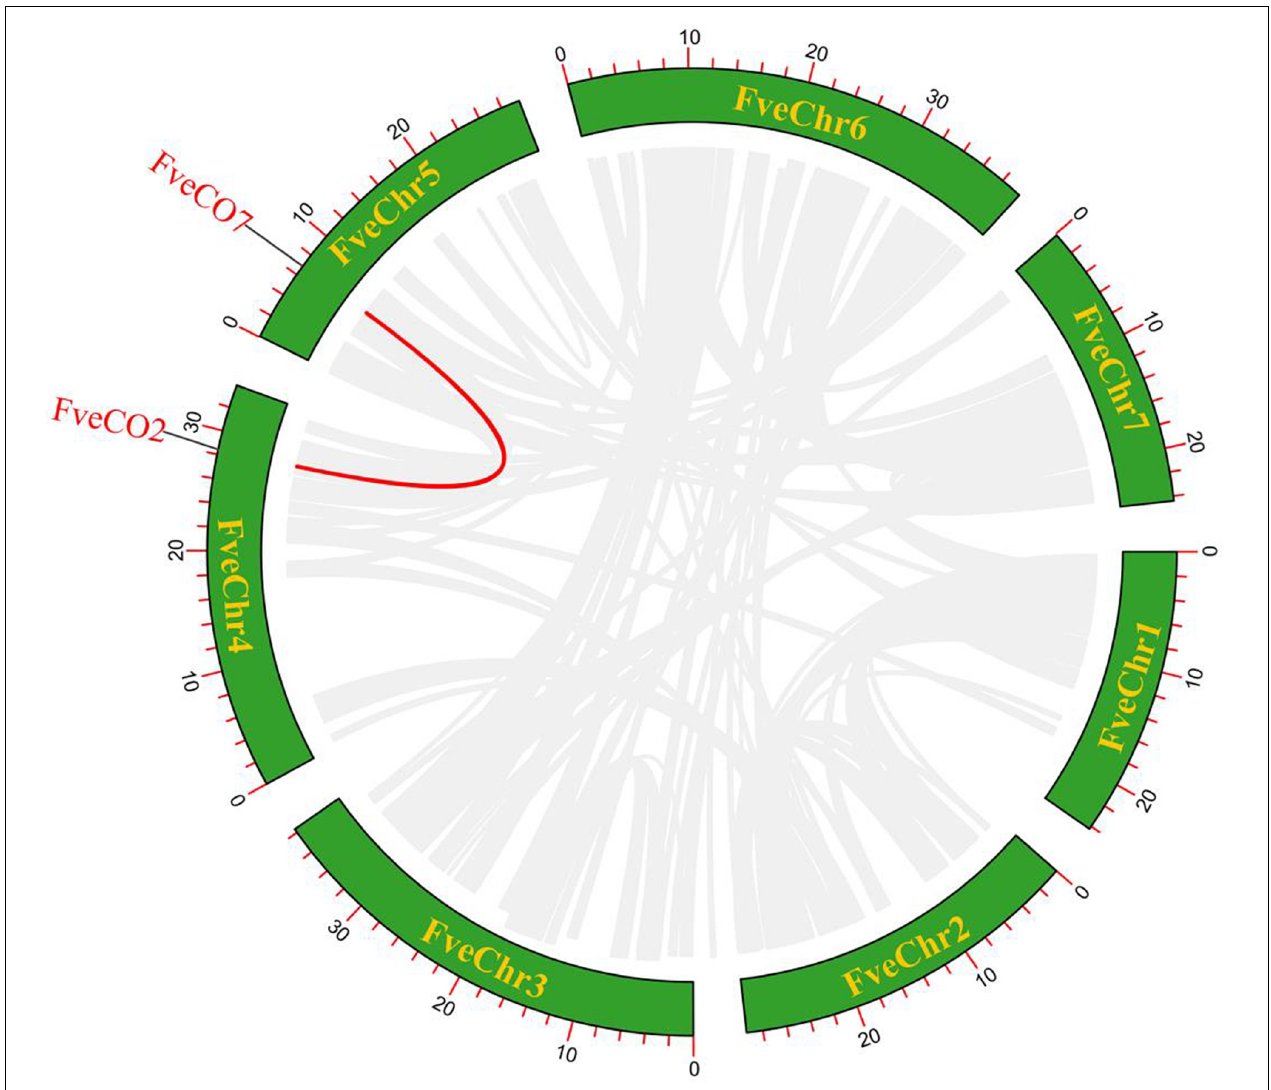
FIGURE 4 | Schematic representation of the interchromosomal relationships between FveCOs in the Fragaria vesca genome. Red line indicates the colinear gene pair, and gray lines indicate the syntenic